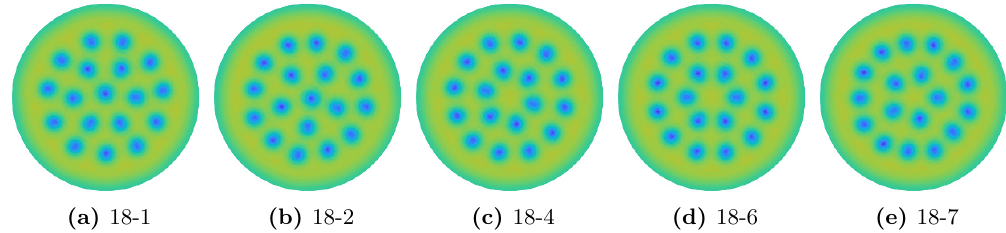
Figure 11. Condensates as functions of space coordinates for lattices with 18 vortices at t = 500. In these evolutions, we choose (cid:10) = 0 : 22 and R =